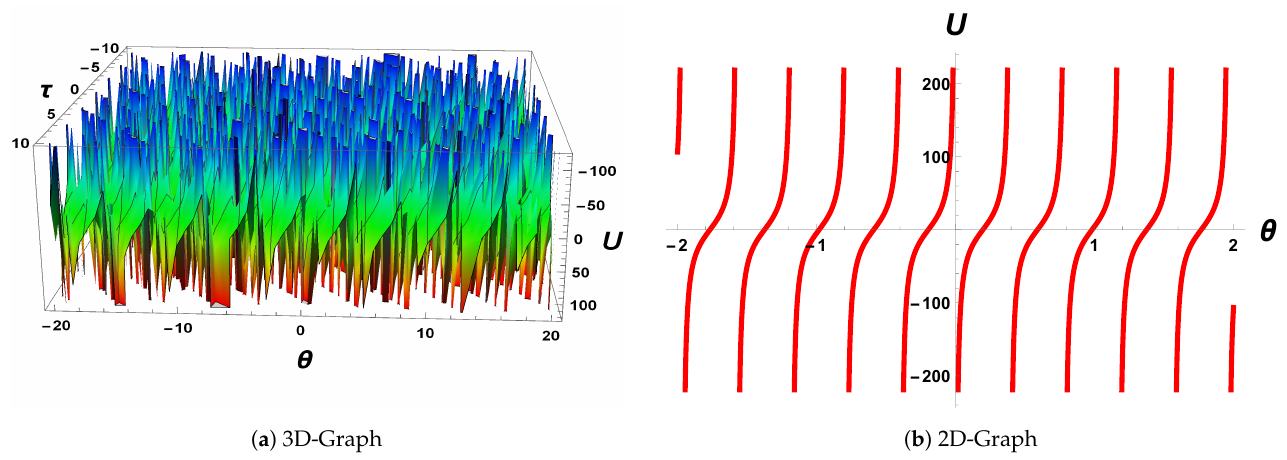
Figure 2. Diagrams a − 3 D and b − 2 D representation of U 2 ( θ , τ ) for l 1 = 0.25, l 2 = 0.50, δ = 0.25, γ 1 = 1.5, γ 2 = 0.10, and γ 3 =